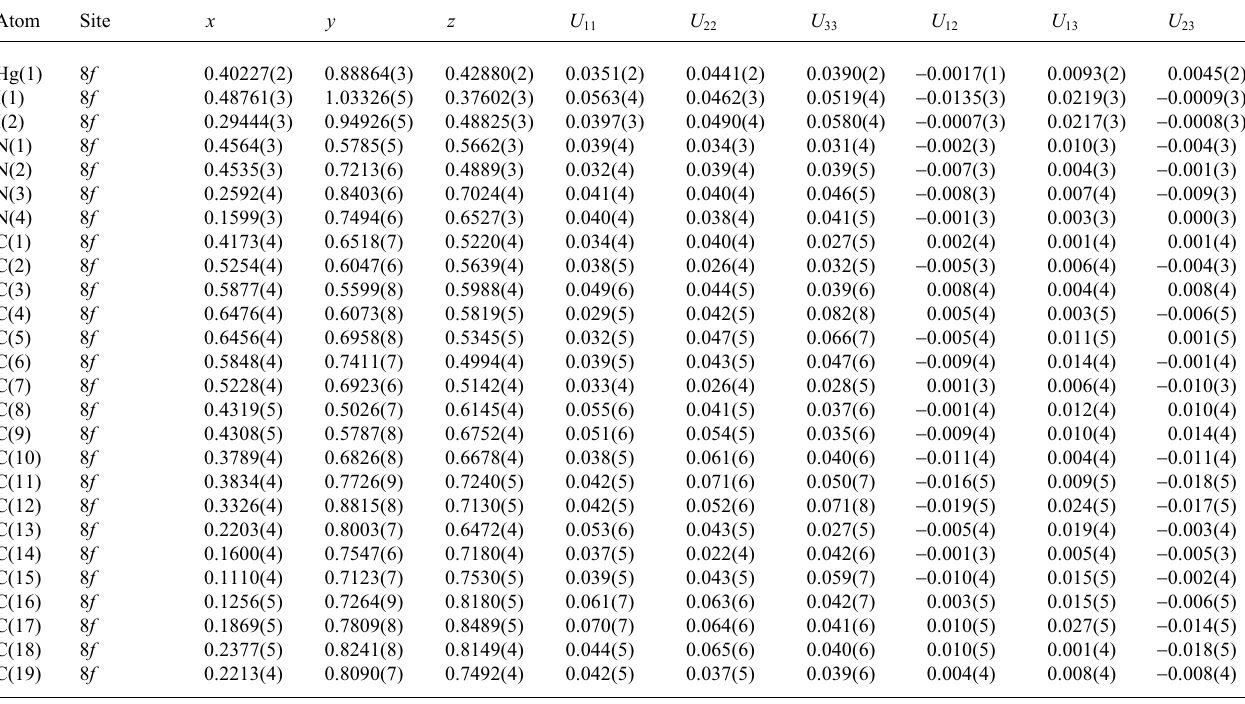
Table 3. Atomic coordinates and displacement parameters (in Å 2 ).